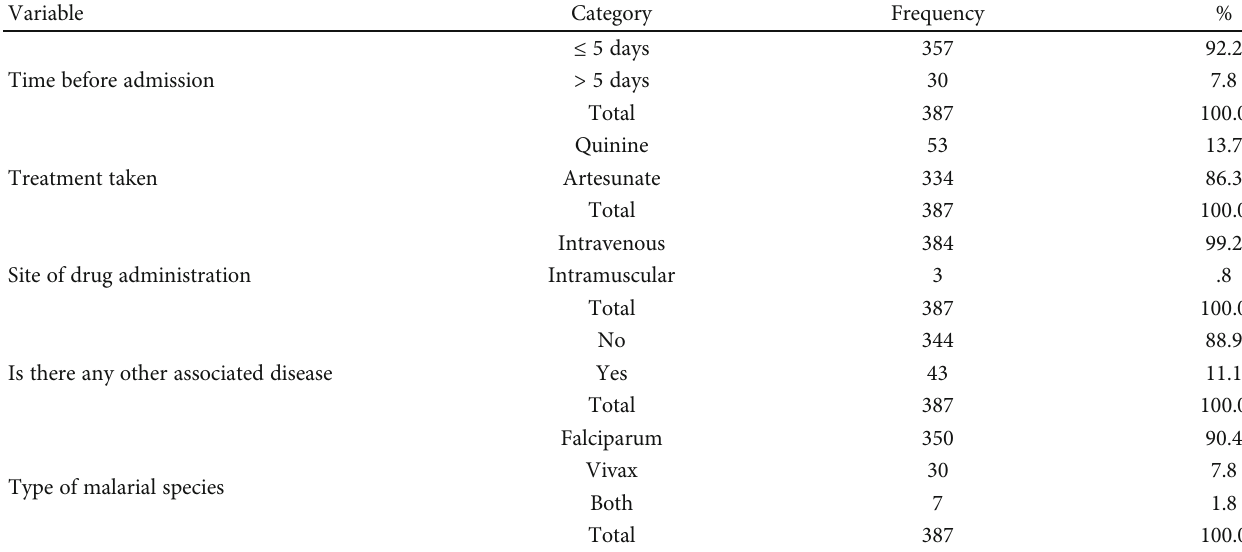
Table 2: Clinical, laboratory, and other related factors of severe malaria in Arba Minch General Hospital from September 2015 to August 2018, n = 387 .